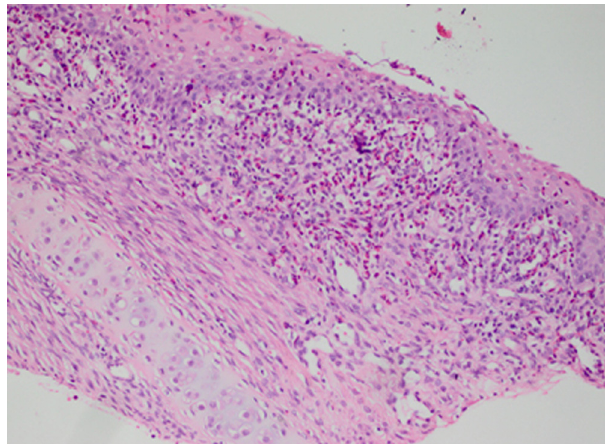
Figure 4 Severe acute inflammation of the submucosa (H---E 200 × ).